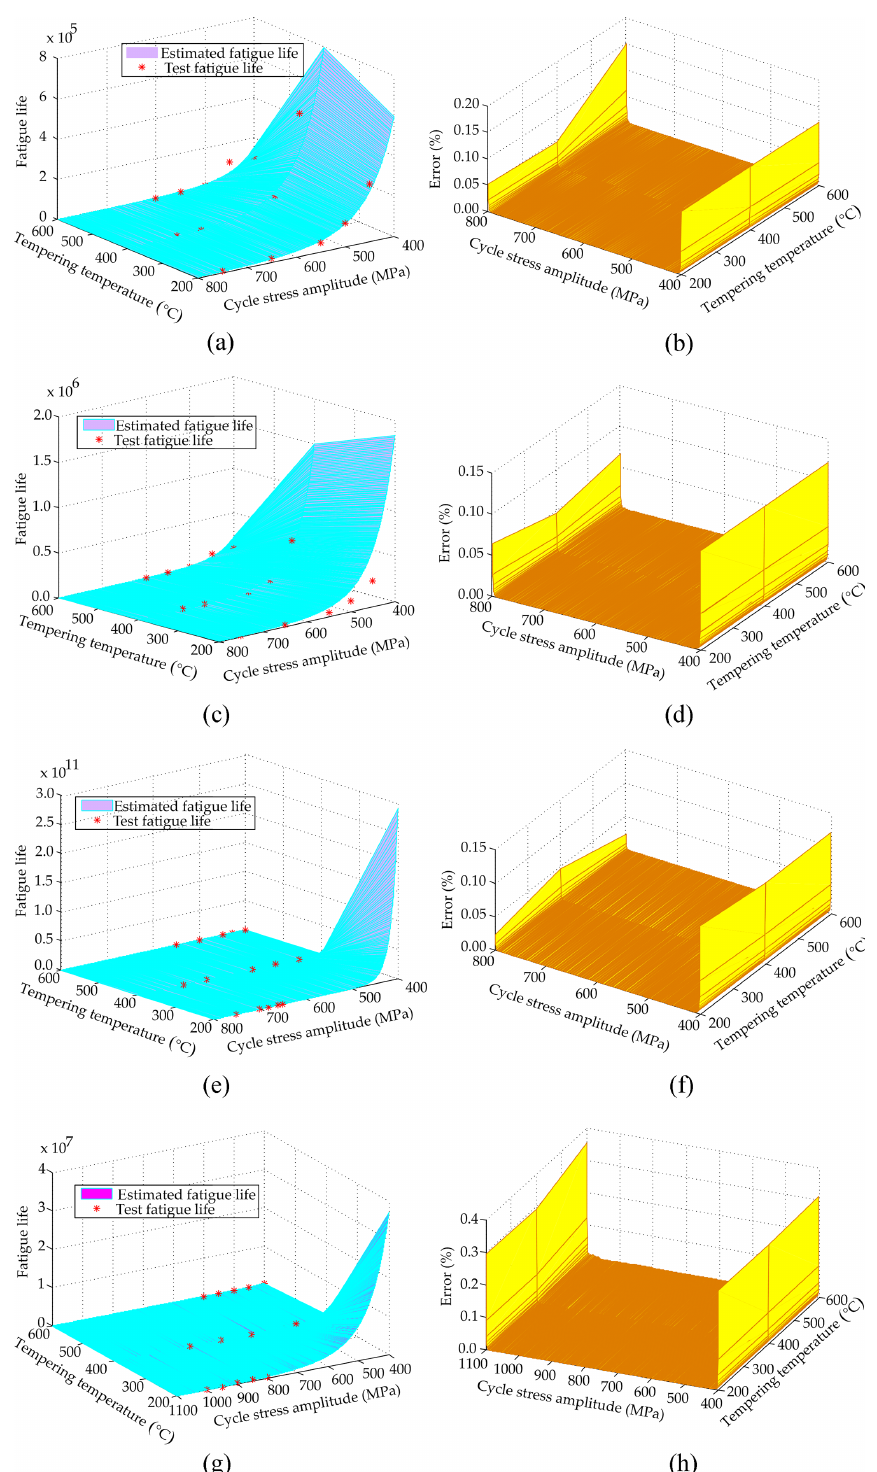
Figure 8. Fatigue life estimated by the presented method based on RBF neural network and the error surface for the test set, (a) fatigue life and error surface, (b) for oil 2, (c) fatigue life and error surface, (d) for oil 1, (e) fatigue life and error surface, (f) for water, (g) fatigue life and error surface, (h) for